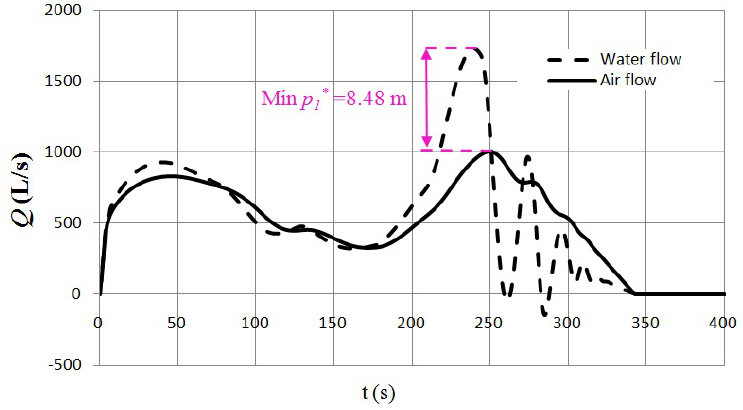
Figure 7. Evolution of the water and air flow in the emptying column